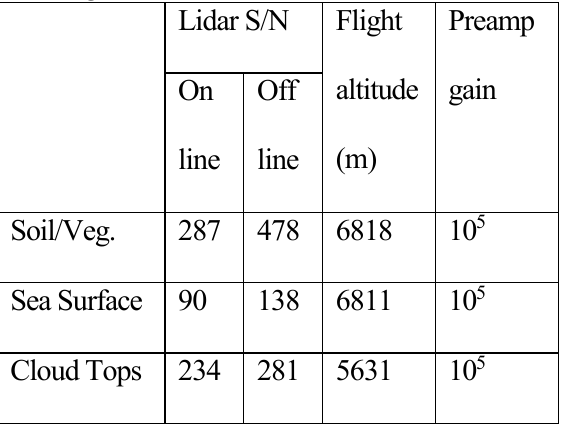
Fig. 1. IPDA lidar signal examples. The preamplifier gain settings are 10 3 and 10 5 for (a) and (b), respectively Table 1. On and Off-line return signal SNR at various ground